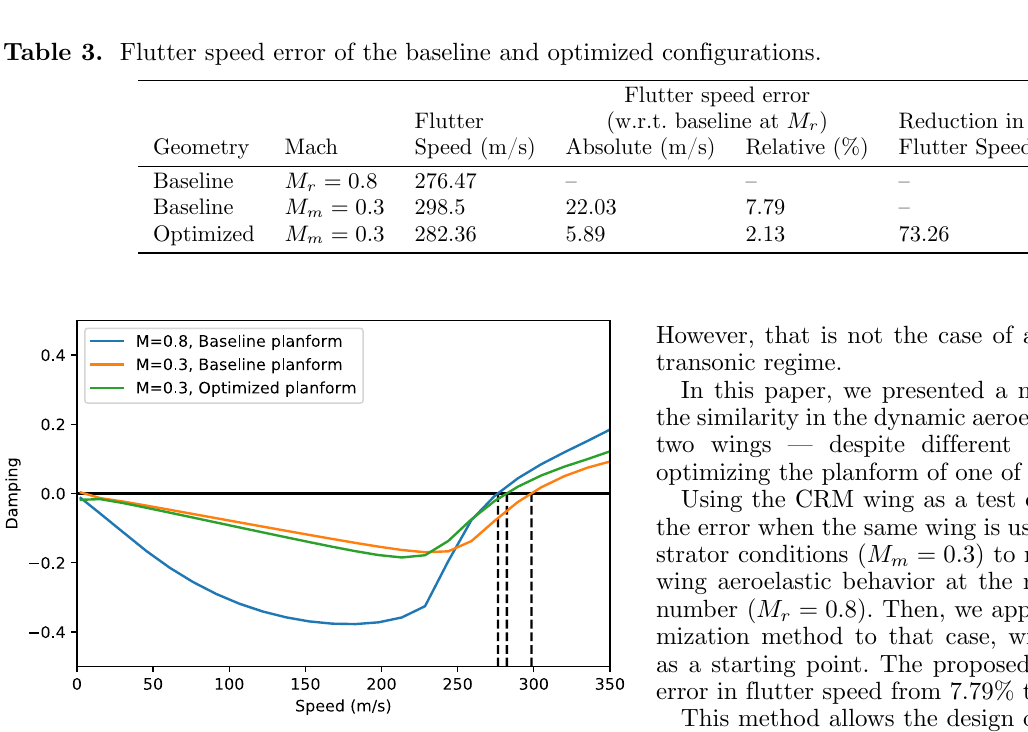
Fig. 6. Baseline CRM wing V - g plots at M = 0 . 8 and for the optimized planform at M = 0 . 3 ; the optimized planform at model conditions brings the flutter speed closer to the one of the reference wing at reference